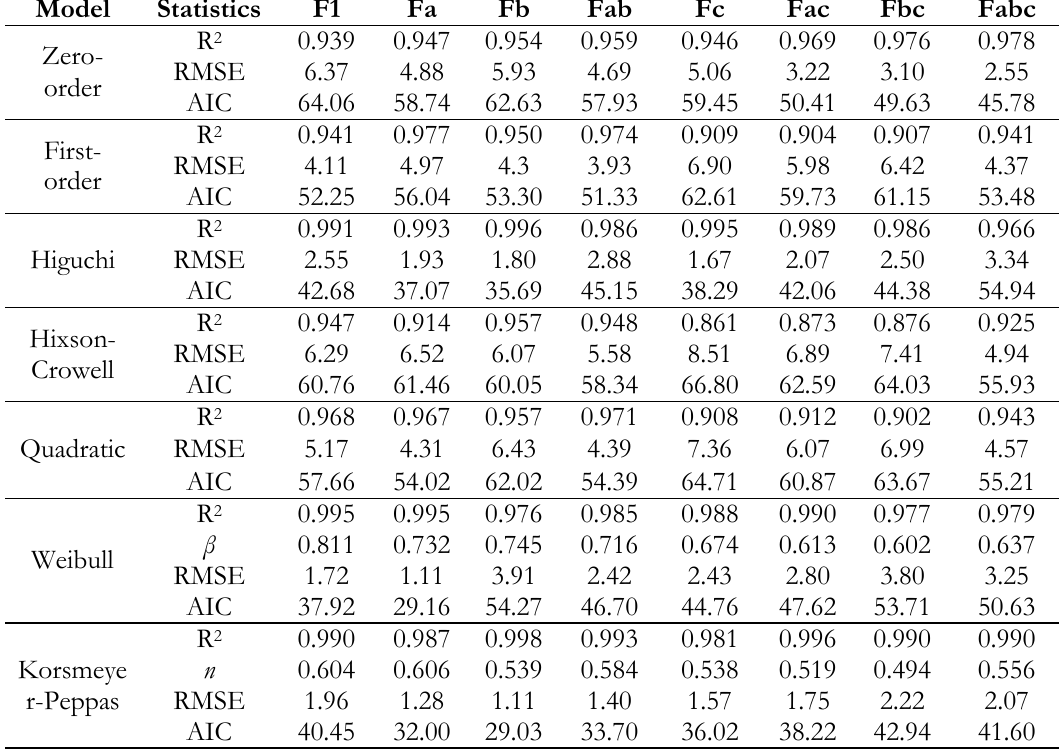
Table II. Kinetics model of drug release from gastro-floating CAP tablet Model